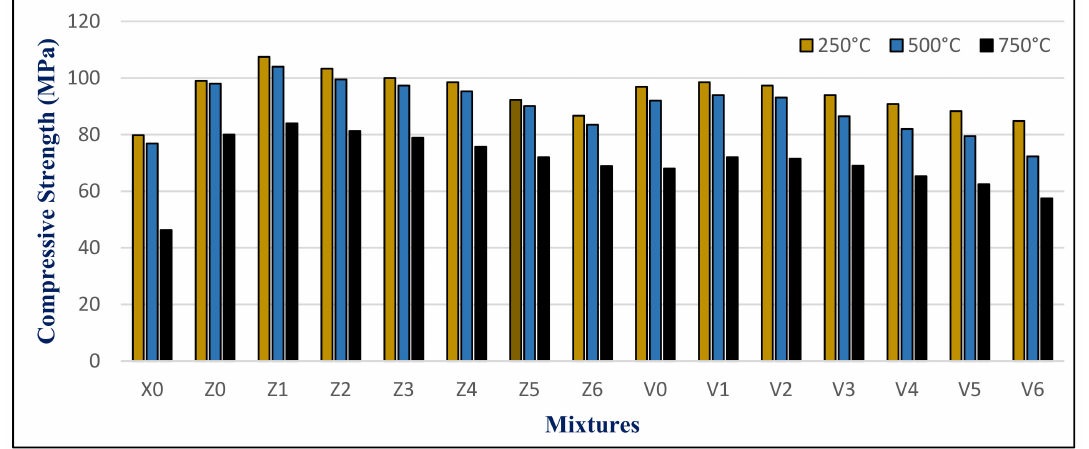
Figure 23. Groups Z and V strength results after exposure to an elevated temperature at 180